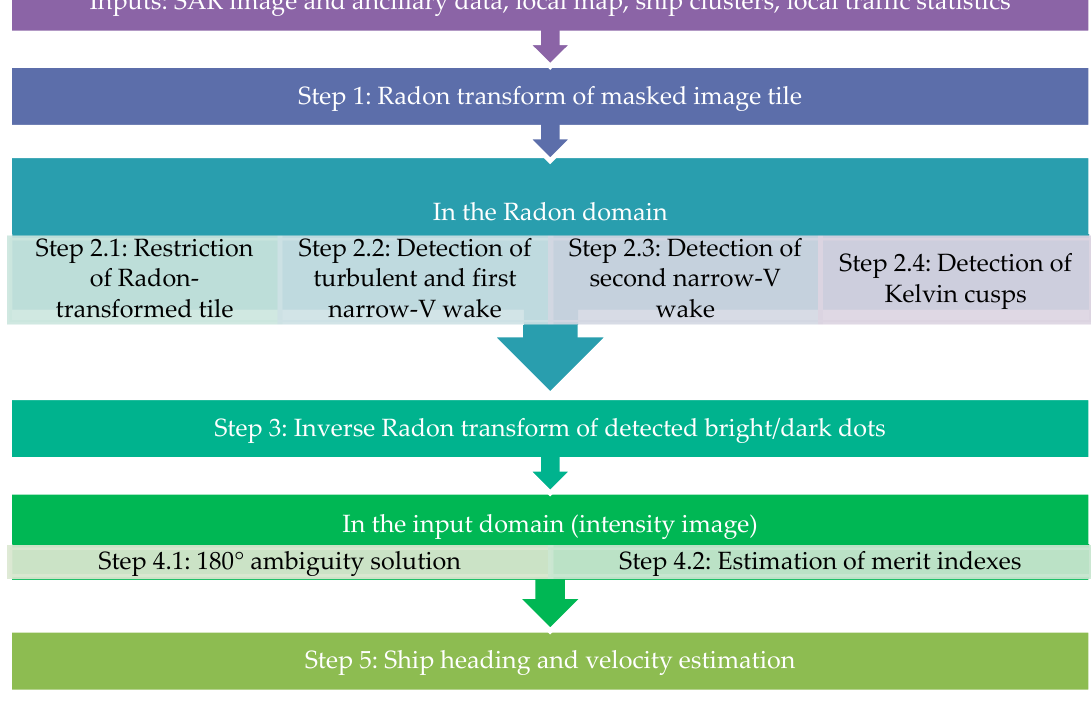
Figure 1. The flow chart of the proposed method.